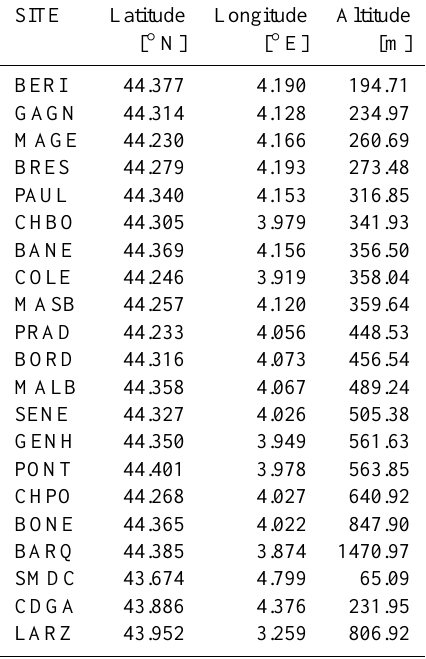
Table 1. Positions of temporary GPS stations in